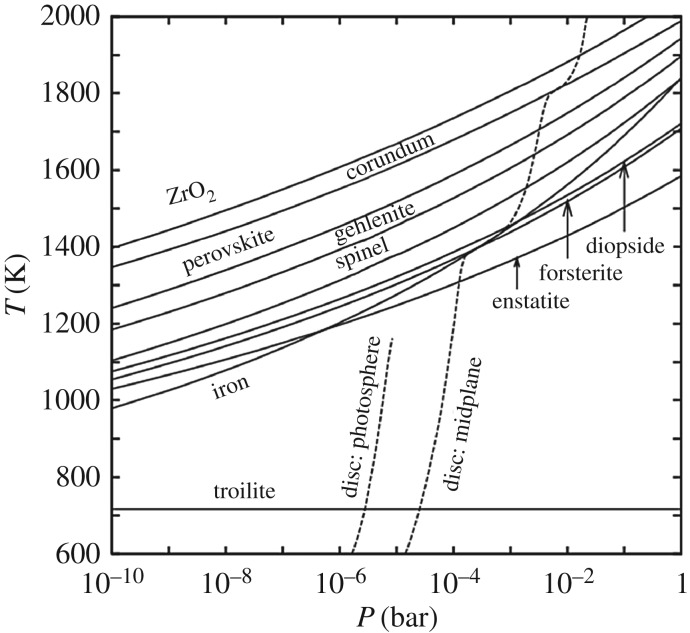
The stability limits of the important solid phases in the pressure regime of interest for accretion discs. Also shown are the typical P–T-combinations in the midplane of the disc and in the disc atmosphere. As the gas cools in the mid-plane, at P>10−3 (bar) Fe-metal grains condense out before forsterite (Mg2SiO4) and enstatite (MgSiO3) (reproduced with permission from [26], fig. 2. Copyright © 2004 Elsevier). See also [44].